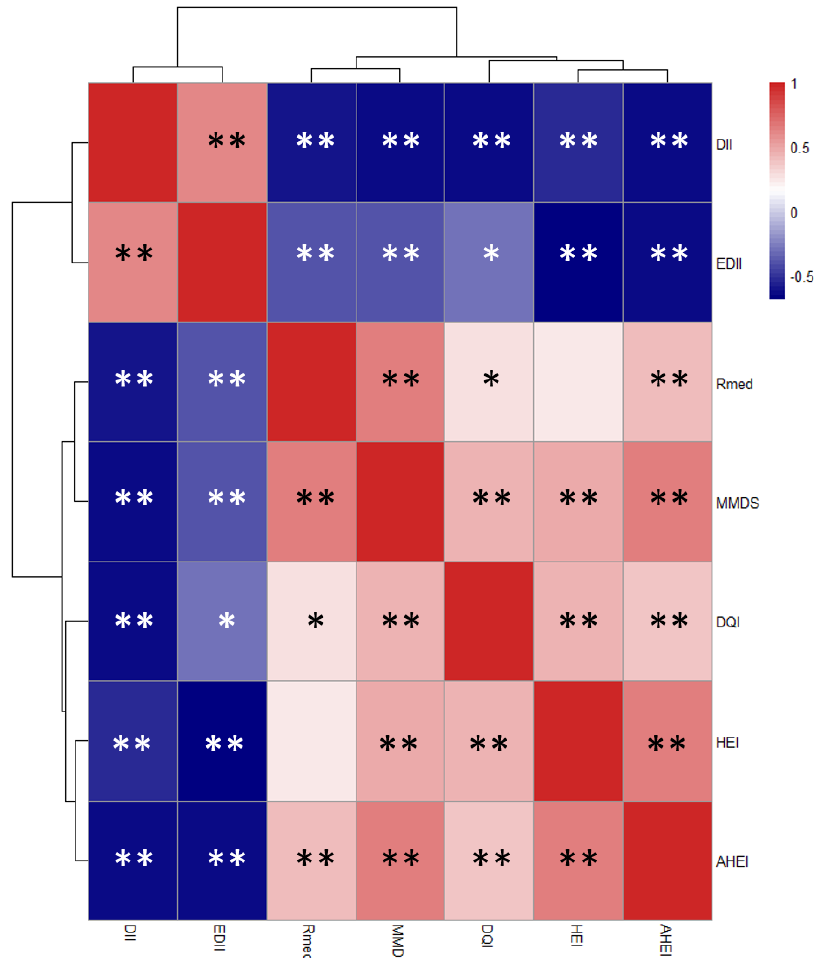
Figure 2. Heatmap defined by Pearson’s correlations between dietary indices scores. Blue and red colors represent negative and positive association, respectively. The color intensity is proportional to the degree of association between indices. Asterisks indicate correlation significance: * p ≤ 0.05; ** p ≤ 0.01. Due to the scale of the Dietary inflammatory index (DII) and the Empirical Dietary Inflammatory Index (EDII), they show an inverse relationship with the rest of the indices.